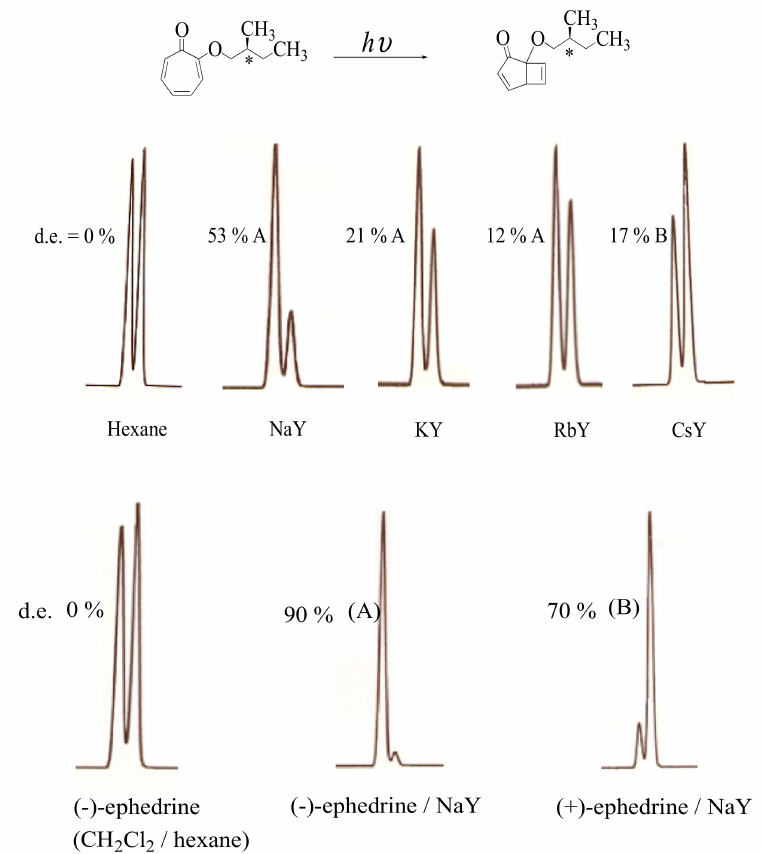
Figure 4. An example of a reaction appended with a remote chiral auxiliary. The e ff ectiveness of the chiral auxiliary is enhanced within chirally-modified zeolites. Top: Chiral induction within achiral zeolites. E ff ectiveness of chiral auxiliary enhanced within zeolites. Bottom: Chiral induction within chirally-modified zeolites. Diastereomeric excess in the range of 90% from zero in solution is